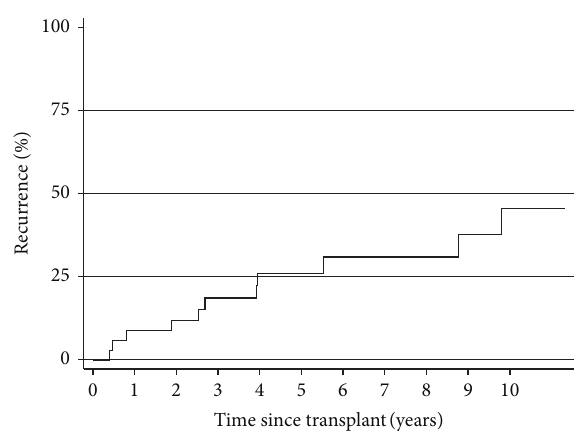
Figure 1: Time to recurrence of membranous nephropathy in first transplants ( 𝑛 = 32 ).